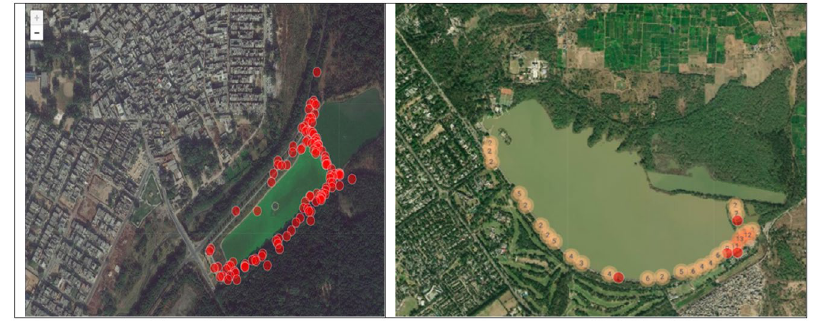
Fig. 2. Sample Collection Table 2. Input data for Computing Indexes S.No.